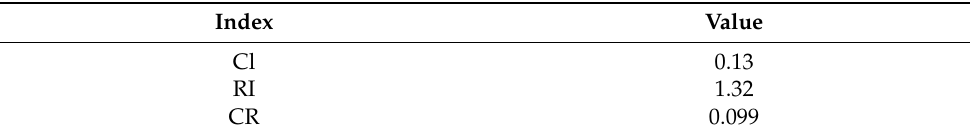
Table 9. Calculation of consistency.